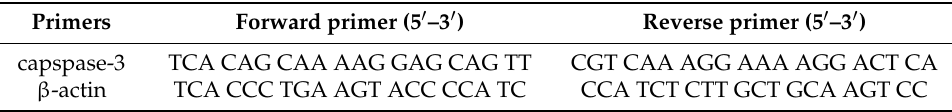
Table 1. The sequences of primers used in